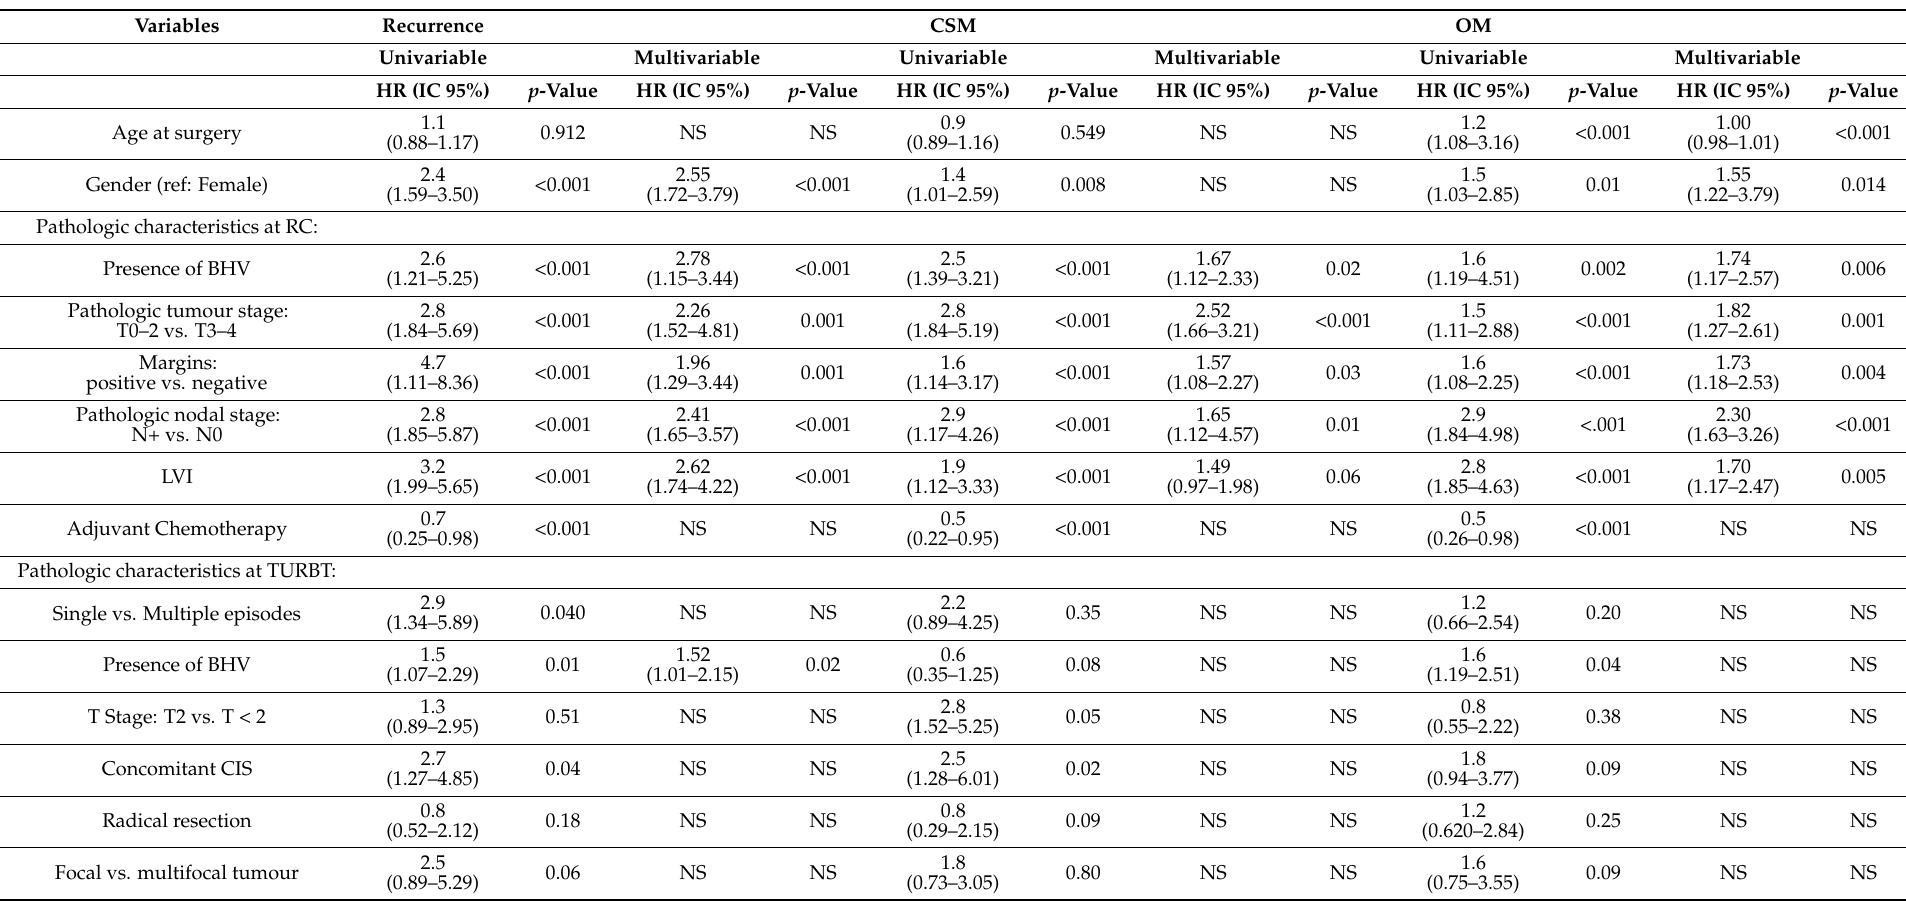
Table 4. Univariable and Multivariable Cox regression predicting disease recurrence, CSM and OM in patients treated with RC based on TURBT features.